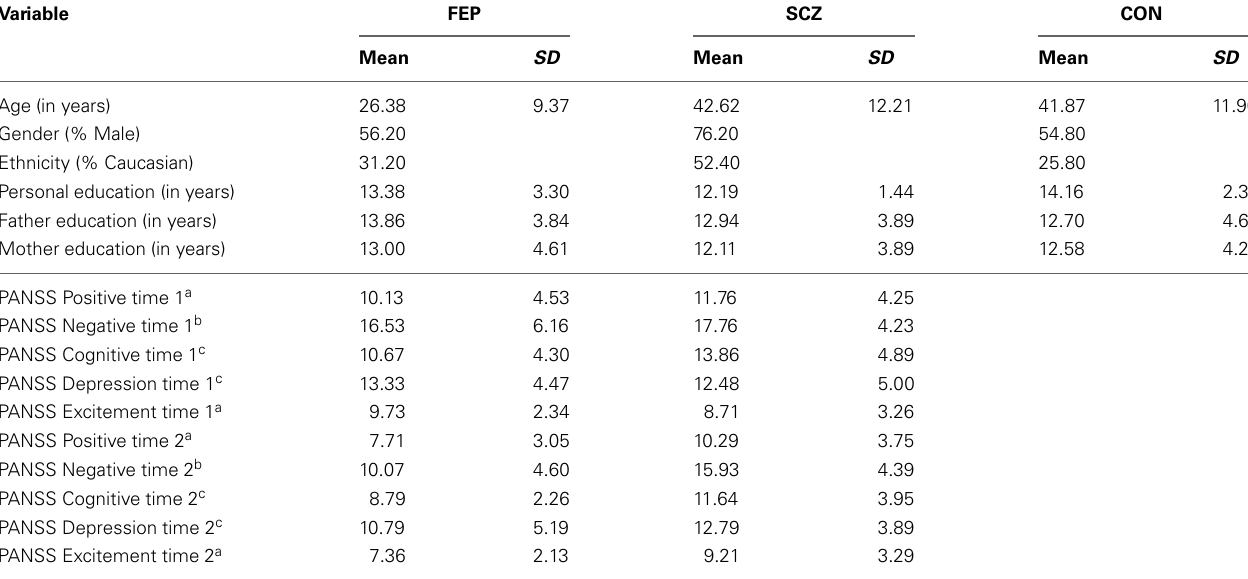
Table 1 | Demographic and clinical characteristics of participants.